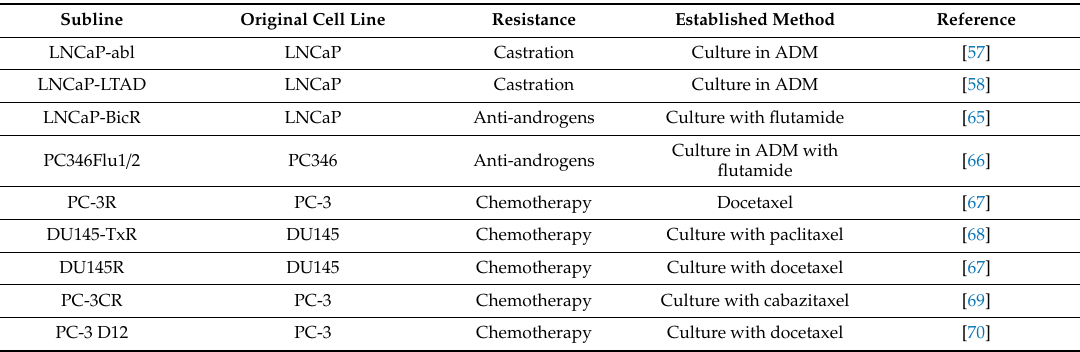
Table 2. Sublines derived from PC cell lines and their resistant